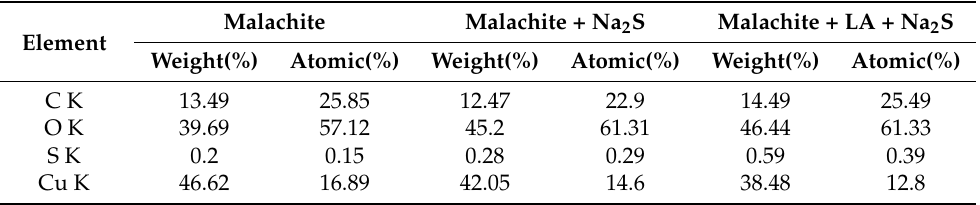
Figure 8. SEM images: ( a , b ) raw malachite; ( c , d ) malachite treated with Na 2 S; ( e , f ) malachite treated Table 1. Results of EDS analyses (%).